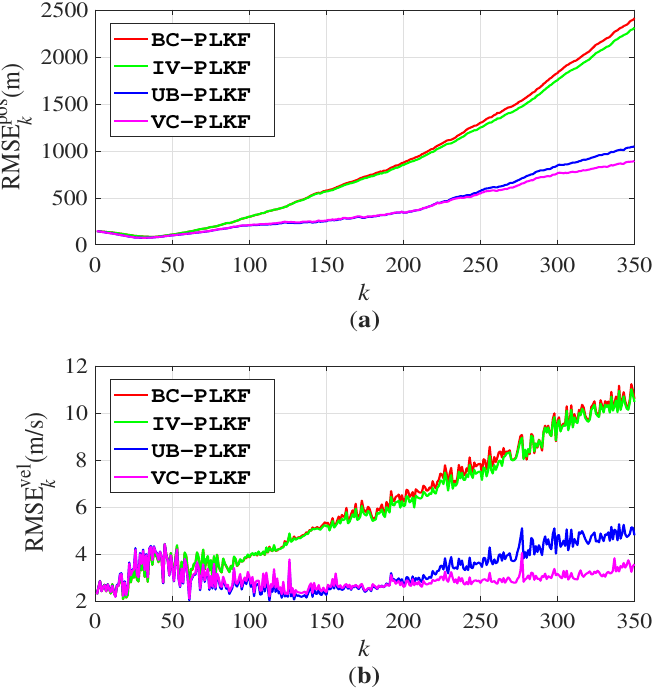
Figure 3. RMSEs for different algorithms in non-manoeuvring target tracking: ( a ) RMSEs for position; ( b ) RMSEs for